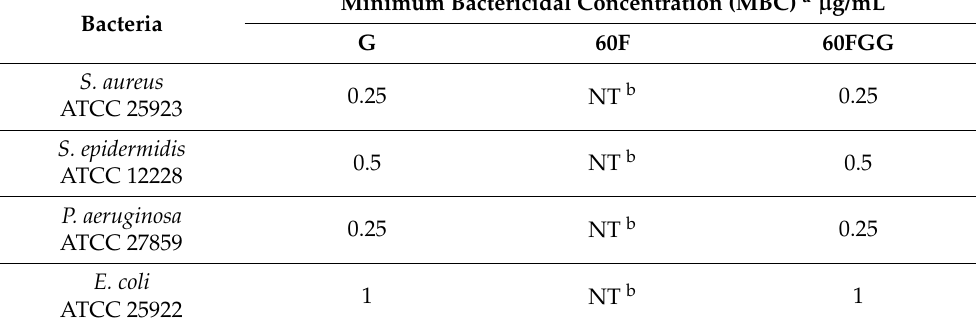
Table 2. MBC values for S. aureus , S. epidermidis , P. aeruginosa , and E. coli after treatment with aqueous solutions of gentamicin sulfate salt ( G ), C 60 fullerenol ( 60F ), and gentamicin functionalized C 60 fullerene ( 60FGG